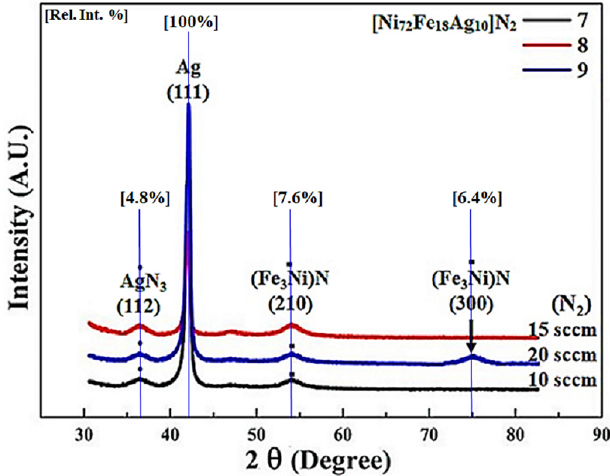
Figure 2. XRD pattern of nitrogenized thin films using target composition Ni 72 Fe 18 Ag 10 , under Ar+N 2 gas mixture with different amounts of reactive nitrogen during sputtering.